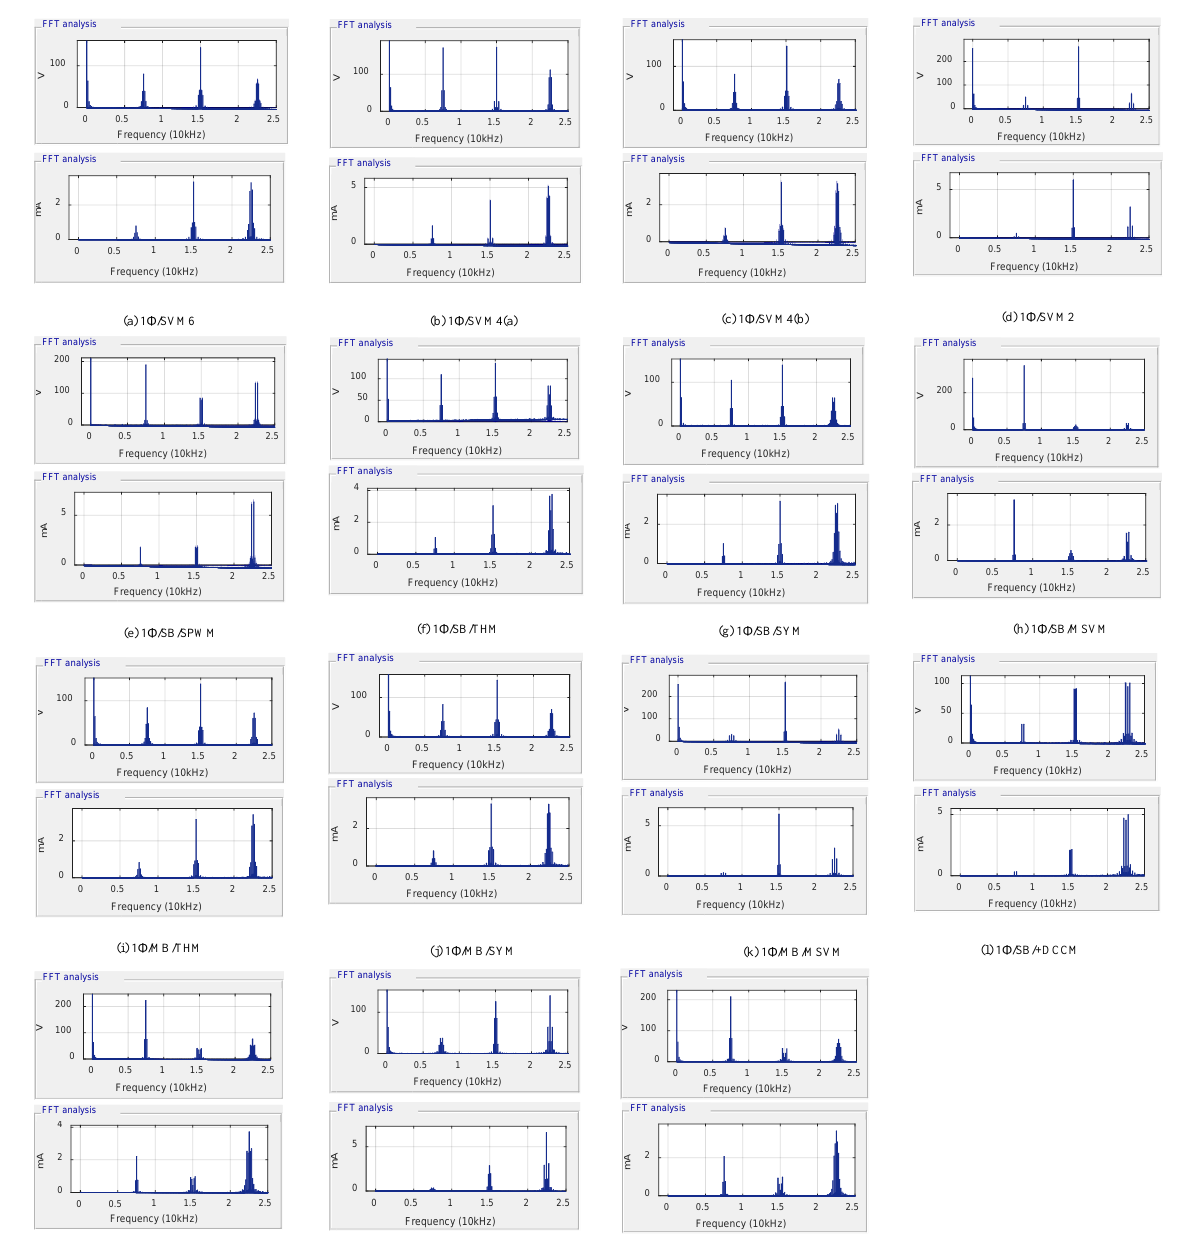
Figure 14. The 1ф ST FFT simulation results of CMV and leak age current waveforms at Vph = Figure 14. The 1 ф ST FFT simulation results of CMV and leakage current waveforms at V ph = 220V.